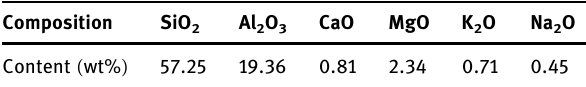
Table 5: Chemical composition of the bentonite